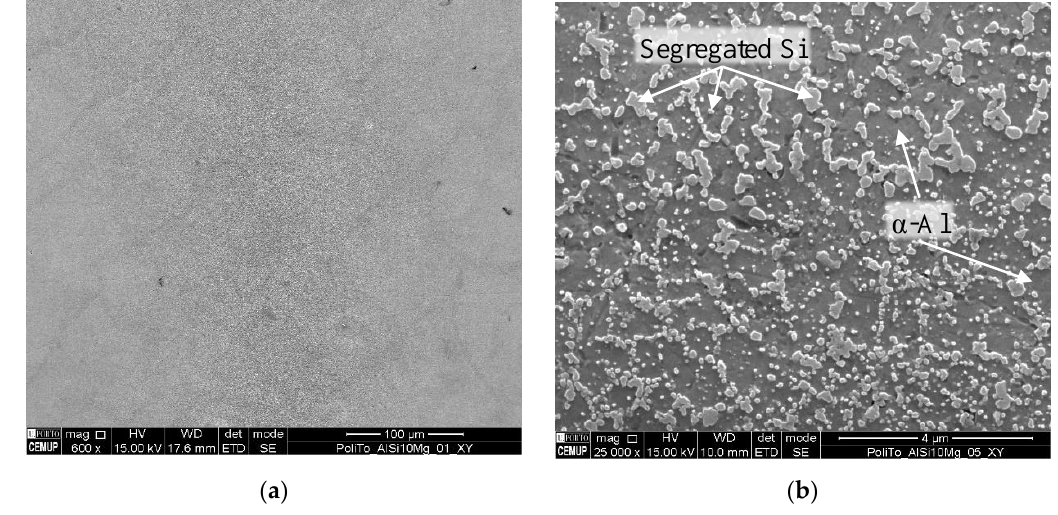
Figure 6. SEM Image of XY Plane of Sample; ( a ) General Overview of Area at 600× Magnification; ( b ) 25000× Magnified Areas, Illustrating Precipitated α–Al Dendrites Surrounded by Segregated Si. Takata, et al. [79], Fiocchi, Tuissi, Bassani and Biffi [42] and Lv , et al. [80] are examples of authors